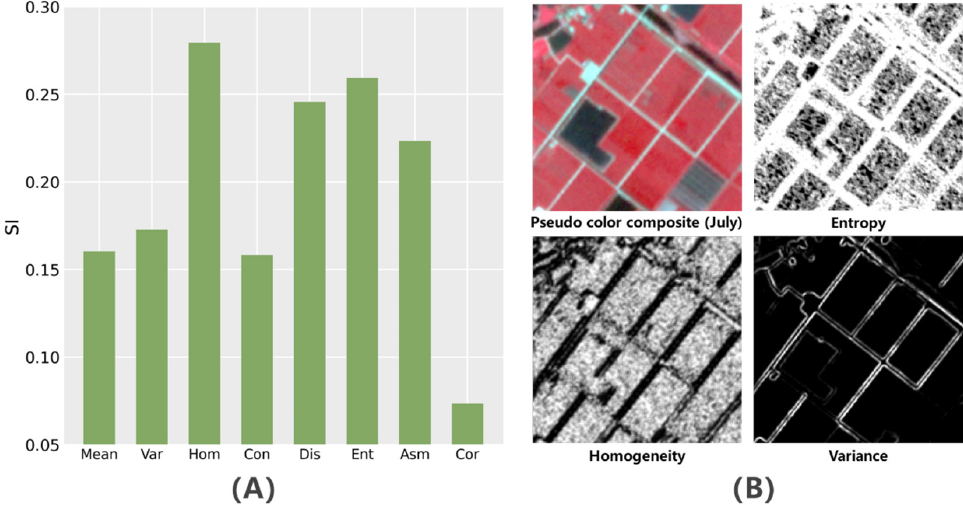
Figure 7. ( A ) Separability index (SI) values calculated for all texture features; ( B ) an example of the selected optimal texture features.